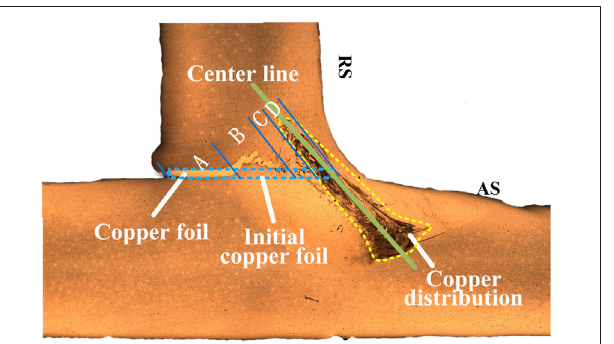
FIGURE 10 | Copper foil